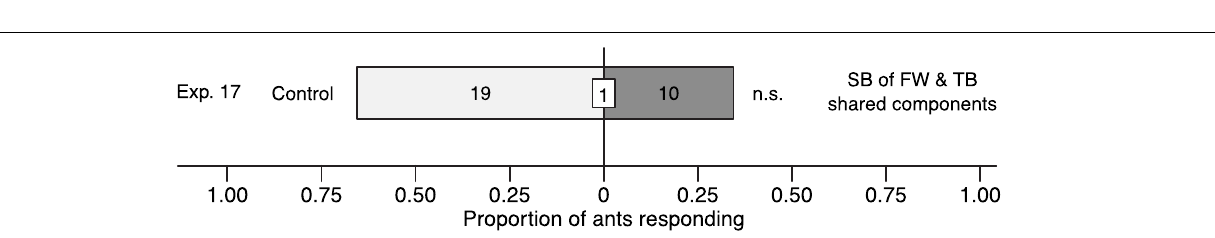
FIGURE 6 | Effect of synthetic blends (SB) of fireweed (FW), thimbleberry (TB), and bird excreta (BE) on responses of C. modoc worker ants in Y-tube olfactometer ( Figure 1 ) experiments 14–16, each with 29–33 responding ants. SBs were formulated in pentane/ether (1/1) and tested at doses equivalent (1 × ) to volatiles released from natural sources (Exps. 2, 3, 8) or 10-fold higher (10 × ). The same volume of pentane/ether (1/1) served as control stimulus. Numbers within bars indicate the number of ants responding to test stimuli and numbers within white inset boxes indicate the number of non-responding ants. Asterisks denote a significant preference for a test stimulus (Pearson’s χ 2 tests: p < 0.05; n. s., not significant).